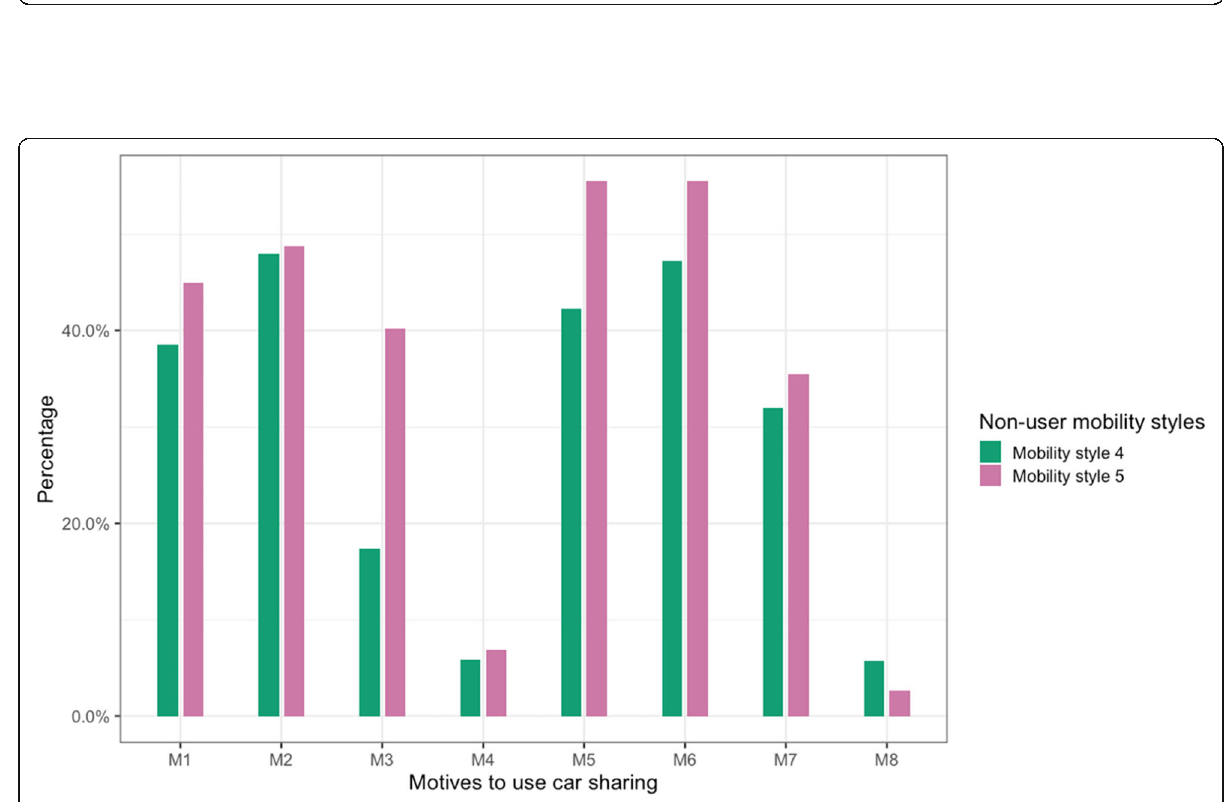
Fig. 1 Percentage of motives selected by user mobility styles, addressed by the question: In your opinion, which of the following motives are incentives for you to use car sharing?. Note: M1 (the accessibility of car sharing parking lots near my place/workplace); M2 (to reduce expenses); M3 (to travel more sustainably); M4 (for more comfort when traveling); M5 (the convenience of having a car only when I need it); M6 (to avoid responsibilities with maintenance and repair of my own car); M7 (to avoid looking for parking spots or other motives); and M8 (other)